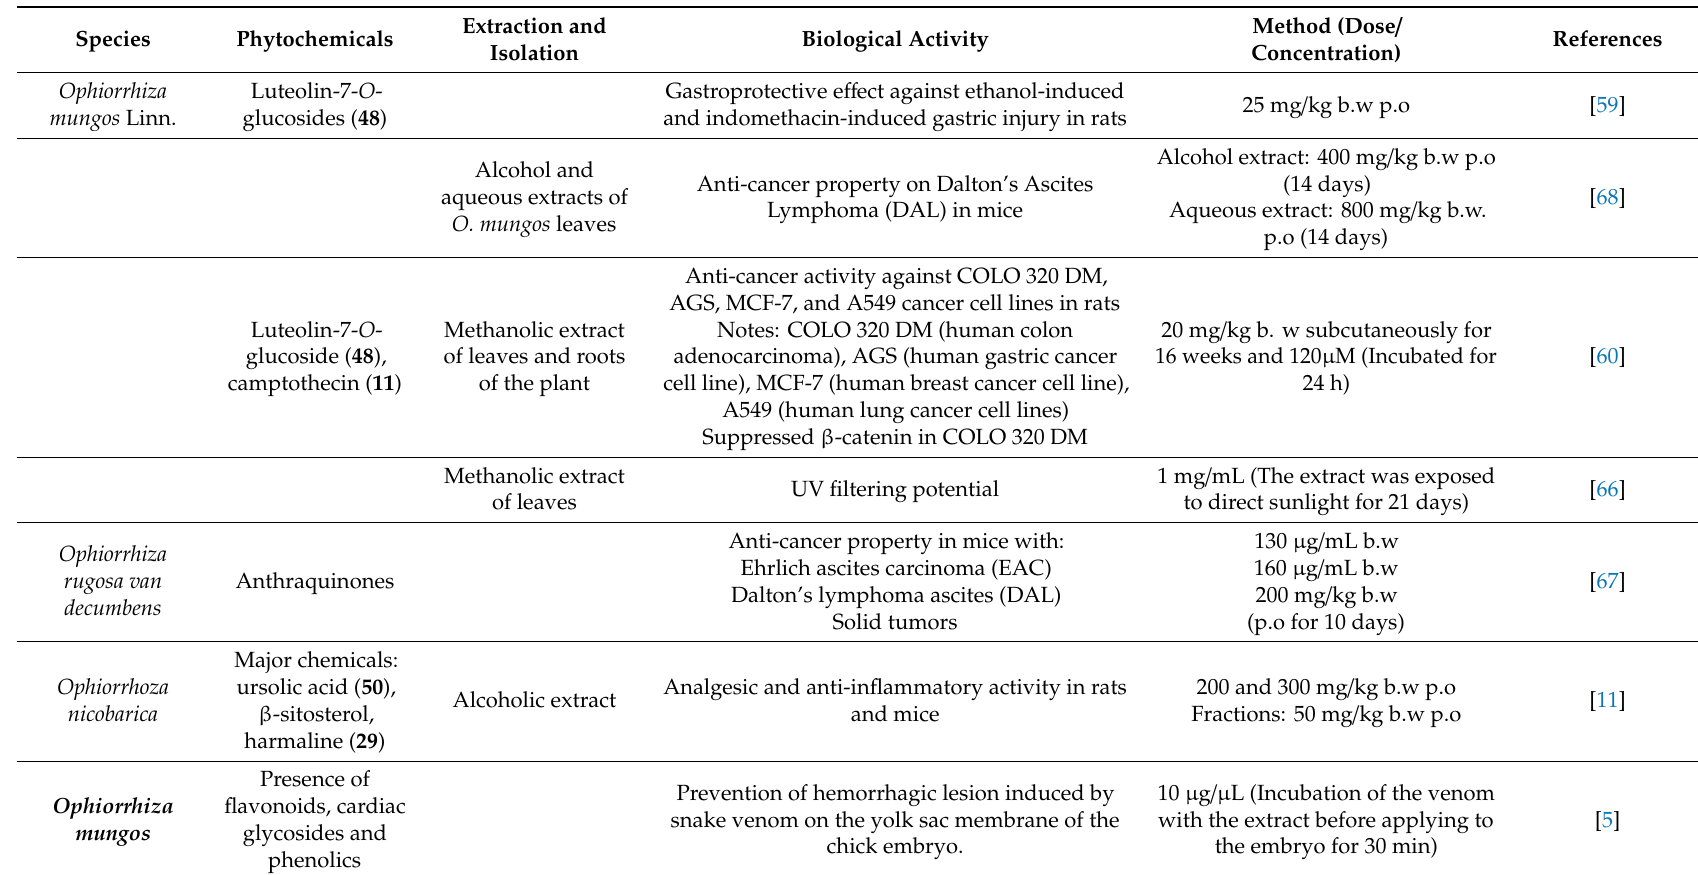
Table 5. Anticancer